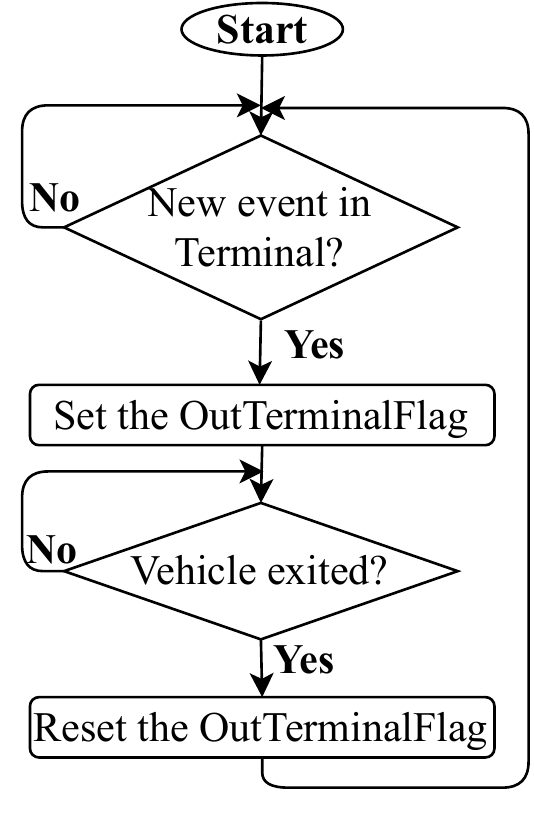
Figure 11. Flowchart of Exit Terminal